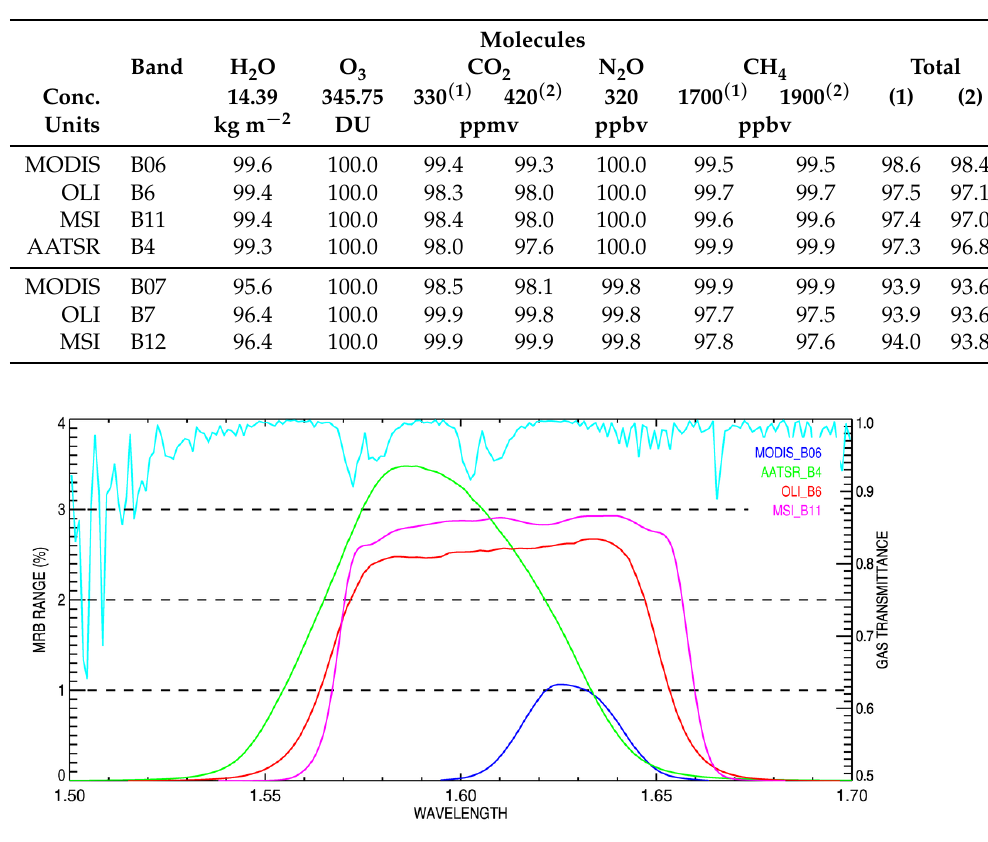
Figure 12. Same as Figure 8 but in the 1.6 µ m spectral region.